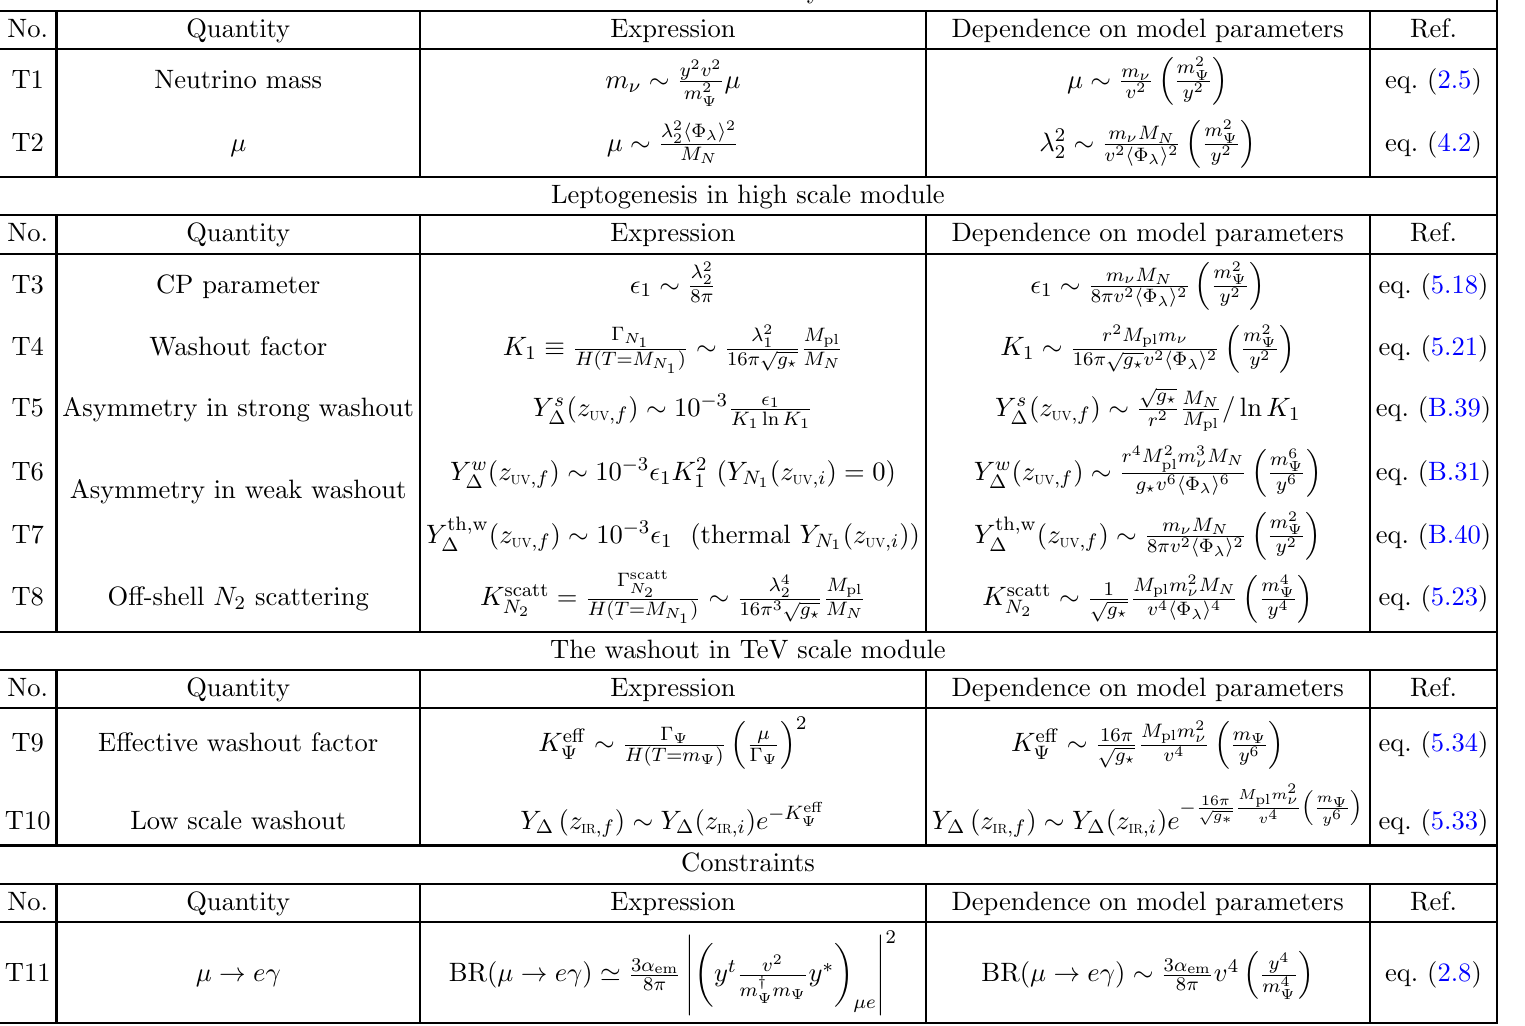
(cid:21) 1 =(cid:21) 2 . High scale and TeV scale modules are de(cid:12)ned in eq. (6.2). Generally we (cid:17)